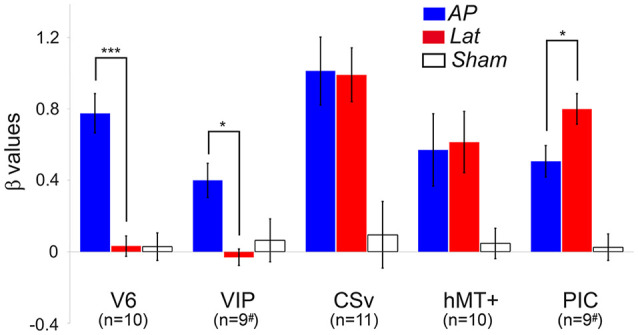
Average beta values obtained in our different ROIs during the antero-posterior (blue) and lateral (red) GVS conditions. Values corresponding to the sham condition are provided in white. The error bars give the standard errors. The # symbols are here to remind that in some subjects, the ventral intraparietal (VIP) and posterior insular cortex (PIC) ROIs were only defined in one hemisphere (see details in the text). We report here the significant differences between AP and Lat conditions (post hoc
t-test, ***p < 0.001, *p < 0.05). The results of the other statistical comparisons are reported in the main document.